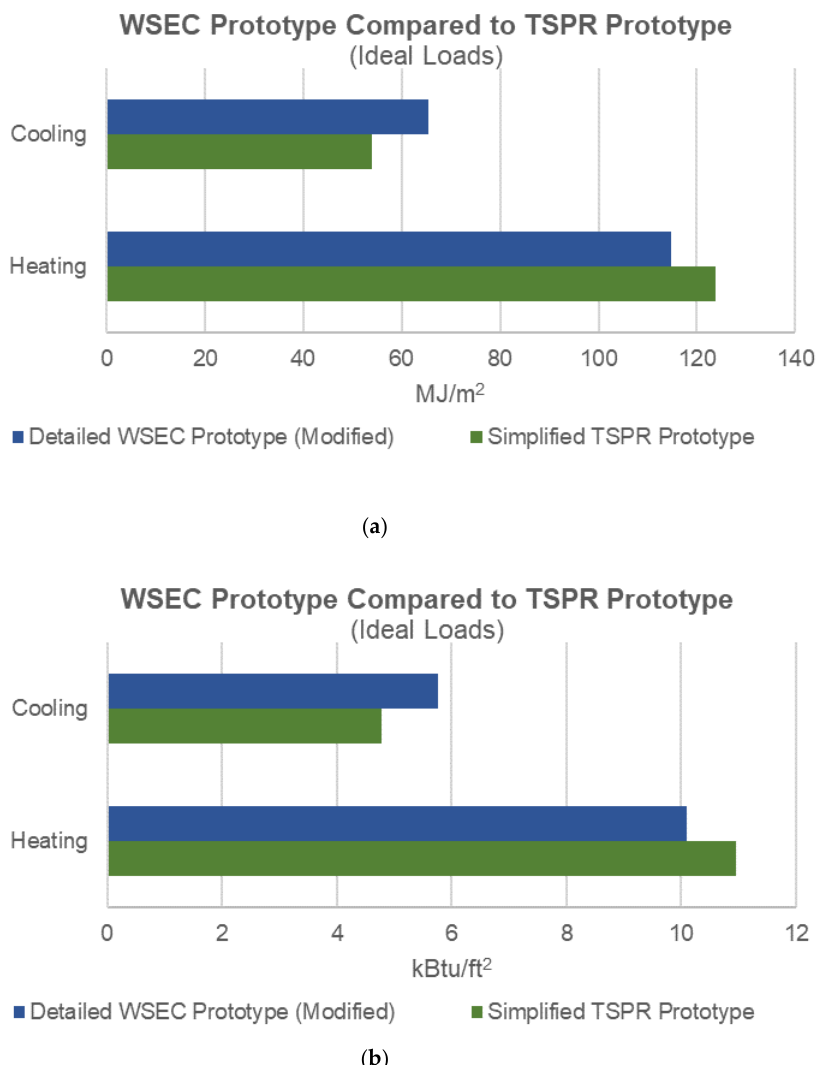
Figure 6. Annual heating and cooling loads comparison of the detailed prototype versus simplified TSPR model. ( a ) SI units; ( b ) IP units.